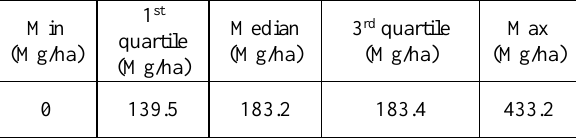
Table 3 . Statistics characteristics of AGB of CFI plots in HWF used for AGB estimation using RF and LightGBM models